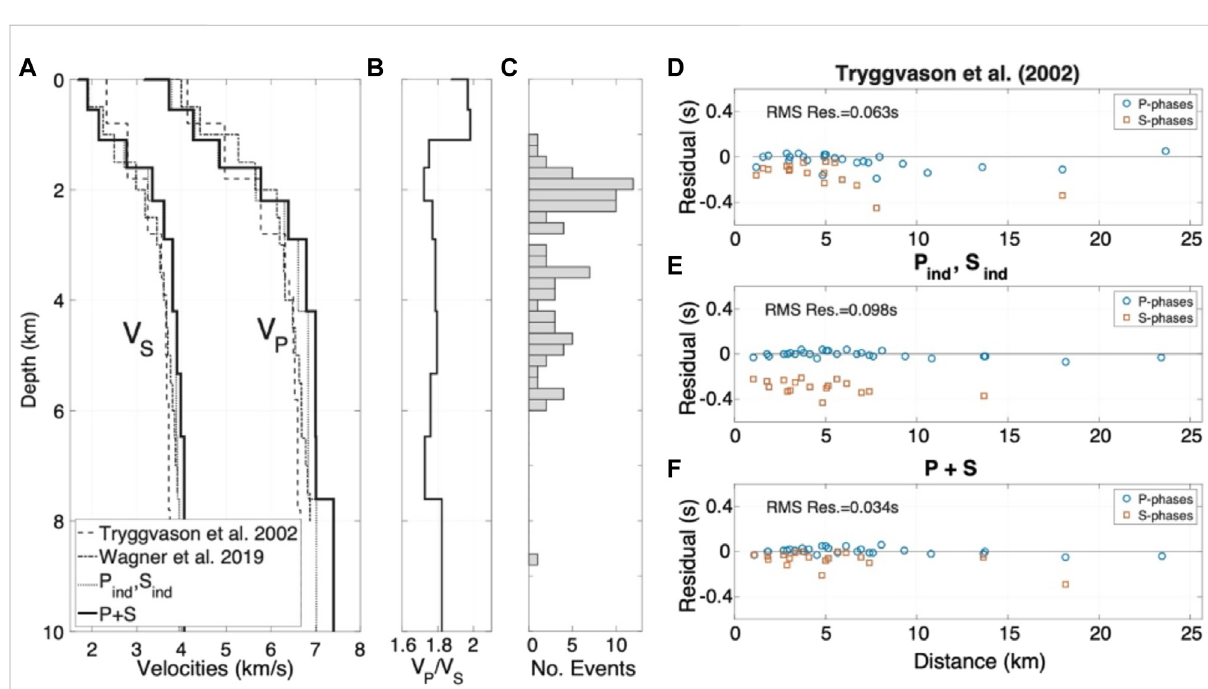
FIGURE 3 (A) Minimum 1-D P- and S-wave velocity models computed for the manually picked catalog. The individually inverted P-and S-wave models (P ind and S ind ) are shown together with the simultaneously inverted models (P+S) and the regional 1-D model that is used for routine locations by ÍSOR (Tryggvasonetal. (2002)). (B) V P /V S ratiofortheP+Smodel. (C) Focal-depthdistributionsderived